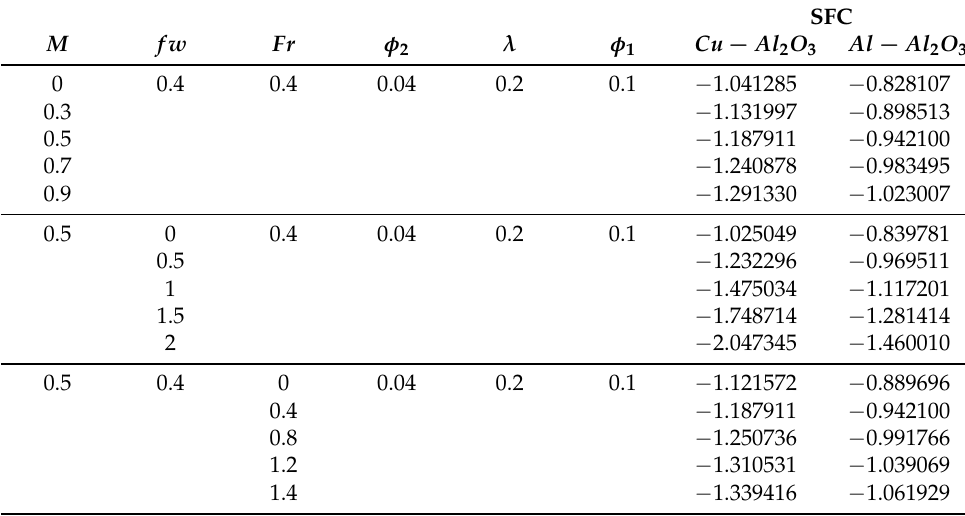
Table 3. The SFC for different values of M , fw , Fr , φ 2 , λ and φ 1 for both